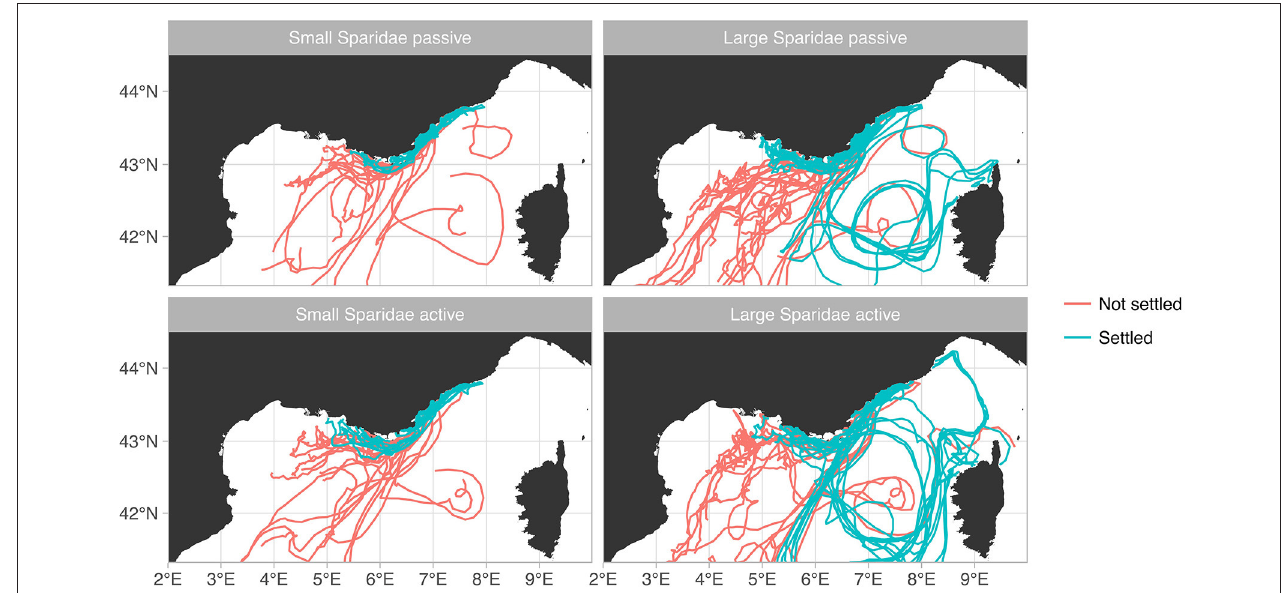
FIGURE 2 | Examples of trajectories from each simulation.